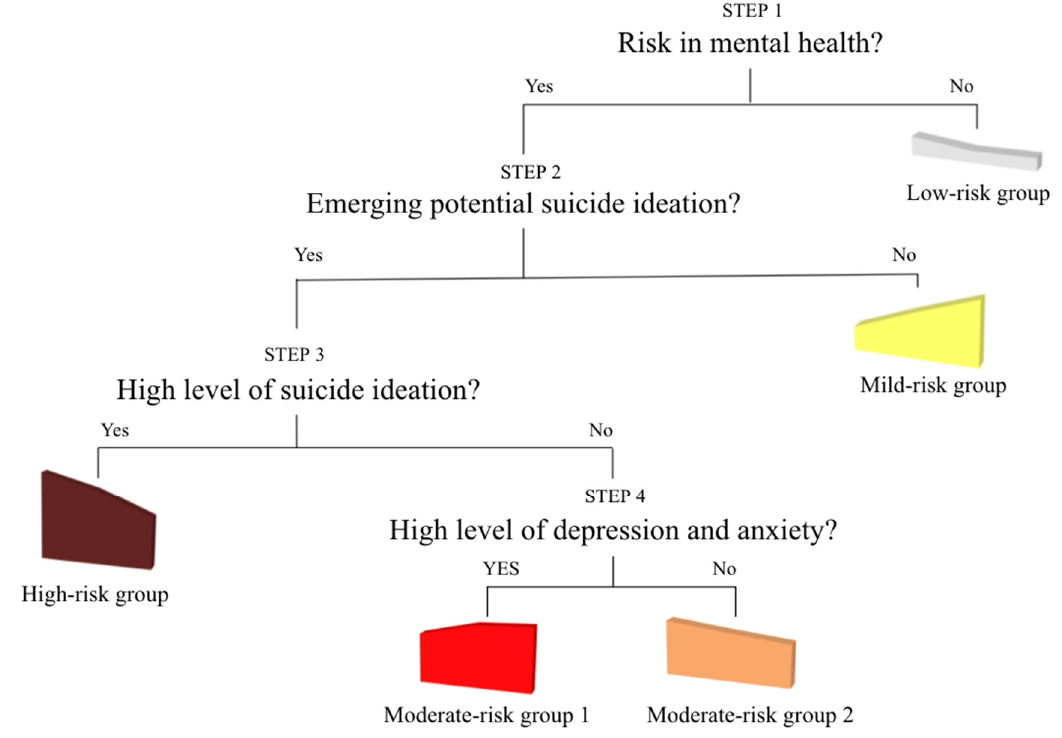
Figure 3. Screening steps across the latent profiles of male students.